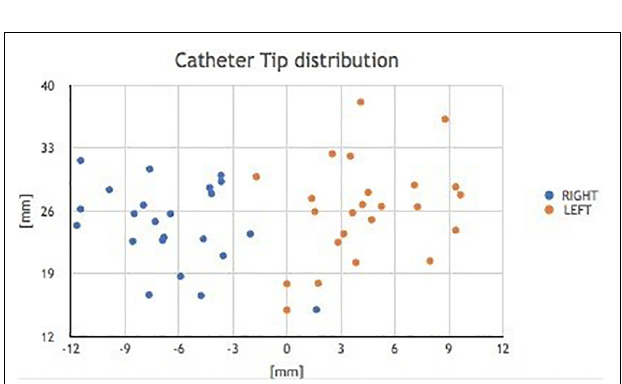
FIGURE 12 | Catheter tip distribution to the right and